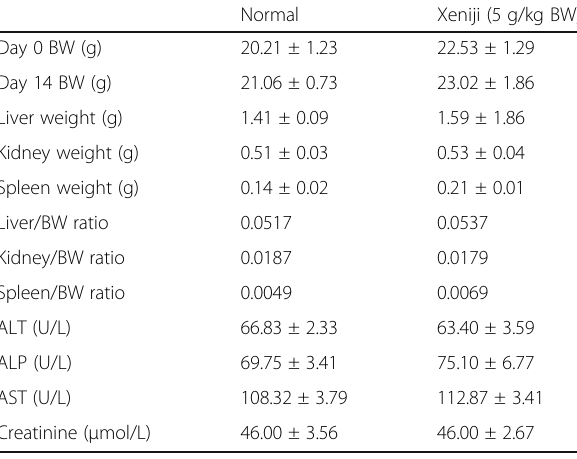
Table 5 Body weight, organ weight and serum liver enzyme profile of normal and 5 g/kg body weight of Xeniji treated mice for acute toxicity study